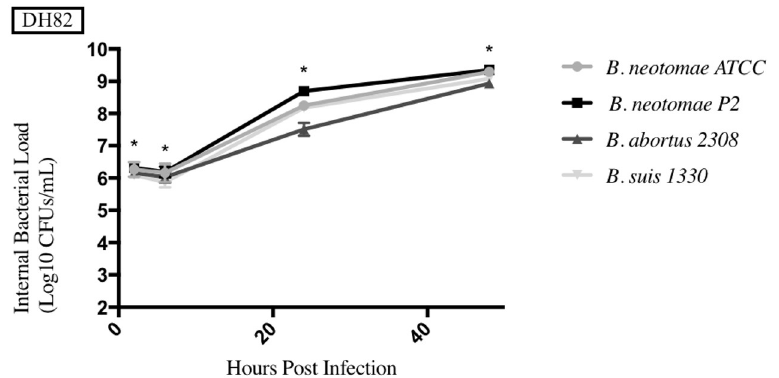
Fig 10. Intracellular survival of Brucella species in the dog macrophage cell line (DH82). Intracellular Brucella spp. CFUs were determined over 48hrs in DH82 as described. Error bars represent the standard deviation of the triplicates from a single experiment. � represents when intracellular CFUs from more than one species tested statistically differs from BN with any p value lower than 0.05.